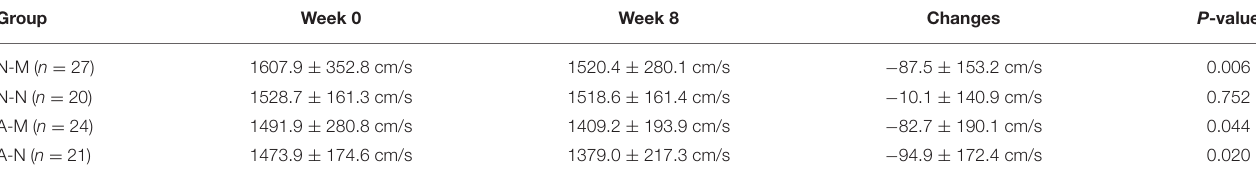
TABLE 5 | Treatment effects on